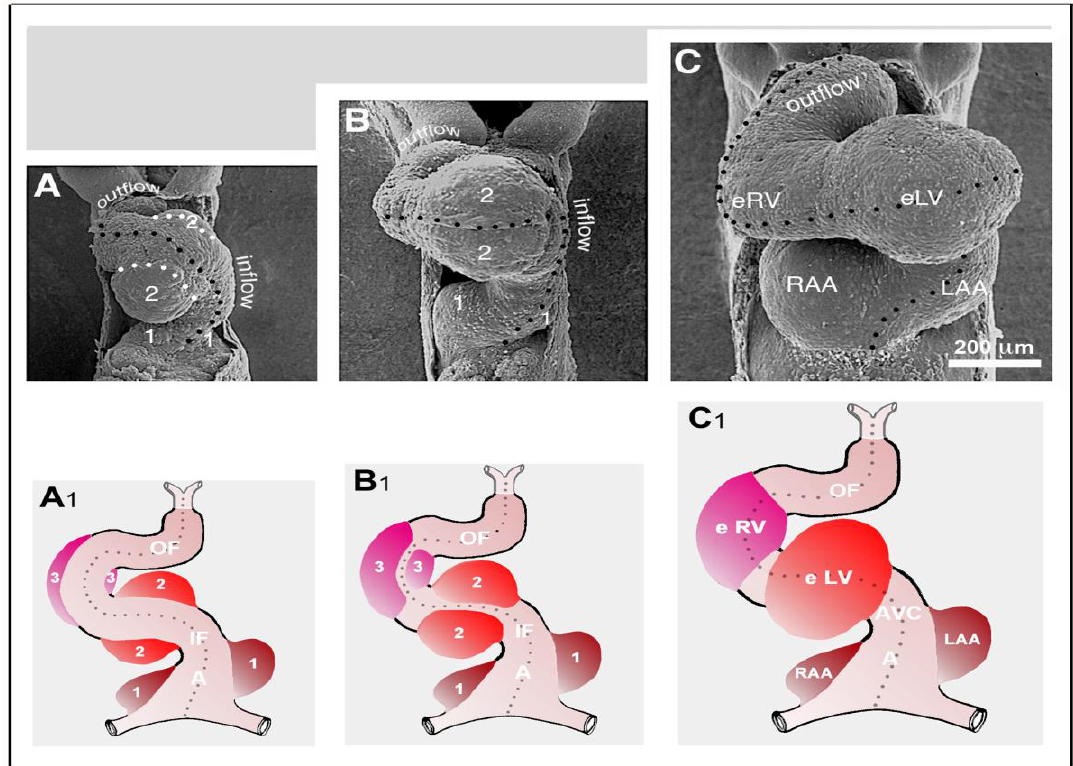
Figure 16. The modified model of cardiac chamber ballooning as depicted by changes in the outer shape of early embryonic hearts. ( A – C ) Scanning electron micrographs of embryonic mouse hearts on ED 8.5 ( A ), ED 9.0 ( B ), and ED 9.75 ( C ). Hearts are shown in fronto-caudal views. This facilitates direct imaging of the surface of the outer curvature of the ventricular bend. The black dotted lines mark the original ventral midline of the heart. Note that the inner curvature is not visible. ( A 1 – C 1 ) Schematic illustrations of the situations shown in Figures A – C . ( A,A 1 ) The initial steps of externally visible chamber ballooning are characterized by the emergence of bilaterally paired ballooning centers at three levels: (1) The embryonic atrium, (2) the prospective left ventricle, and (3) the prospective right ventricle. The white dotted lines in Figure A mark the ventral borders between the remnant of the primary ventricular tube and the paired ballooning centers of the prospective left ventricle. ( B,B 1 ) Due to expansion of the paired ballooning centers of the prospective ventricles, their ventral borders shift toward the original ventral midline of the ventricular bend. ( C,C 1 ) The originally paired ballooning centers of the prospective ventricles unite to form single units (embryonic left and right ventricle) that give rise to the apical trabeculated regions of the prospective ventricles. The paired ballooning centers of the embryonic atrium remain separated and give rise to the atrial appendages of the mature heart. Same abbreviations as used in Figure